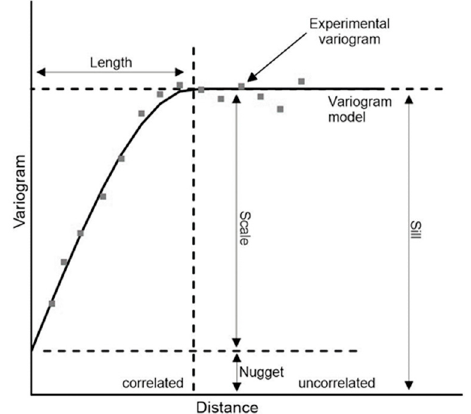
Figure 4. Experimental and variogram model with corresponding parameters. The total sill ( σ 2 ) corresponds to the sum of the nugget e ff ect and partial sill (the maximum variability degree of the process); the range ( α ) can be interpreted as the distance beyond which the spatial correlation becomes negligible